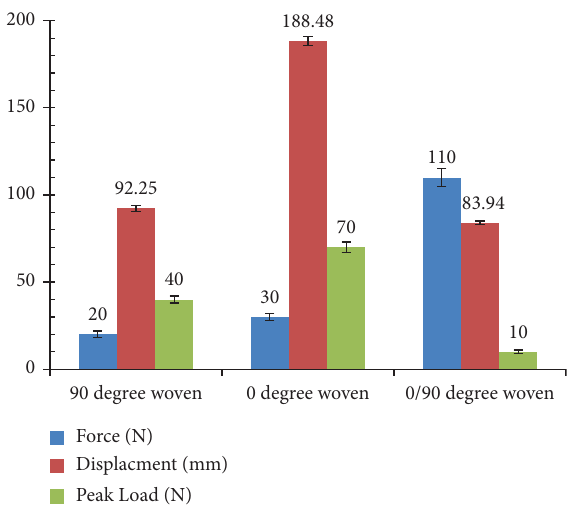
Figure 18: Buckling test result comparison.